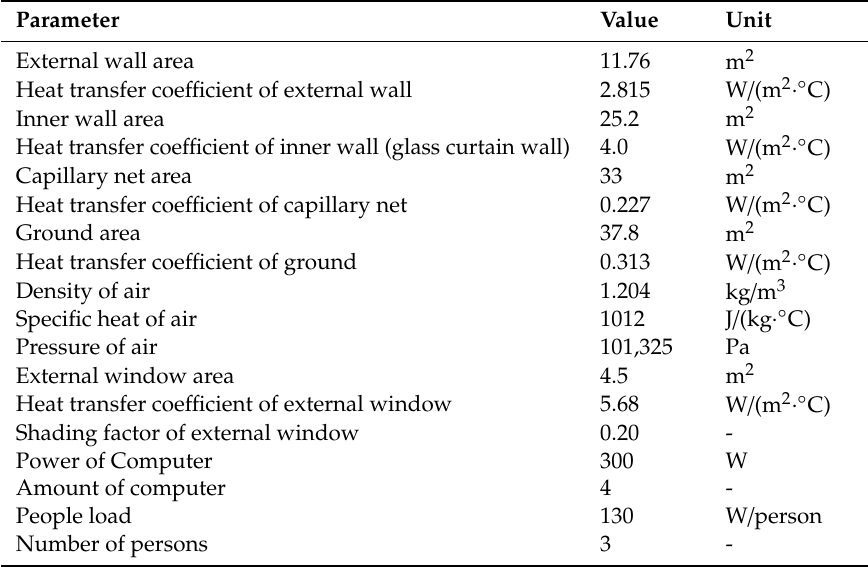
Table 2. Depiction of the experimental room.